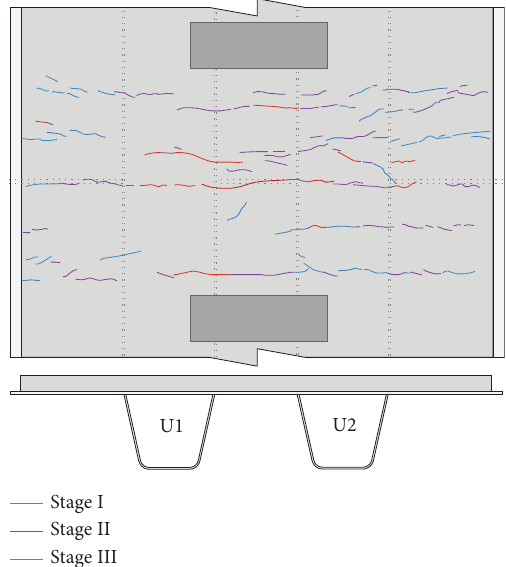
Figure 17: Crack distribution in the UHPC layer.